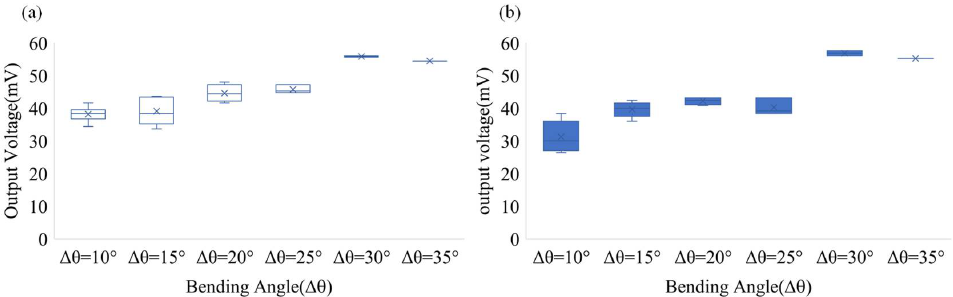
Figure 12. Piezoelectric variation of robotic arm at different angles in different directions. ( a ) Piezo- electric variation of robotic arm when falling at different bending angles; ( b ) Piezoelectric variation of robotic arm when rising at different angles.